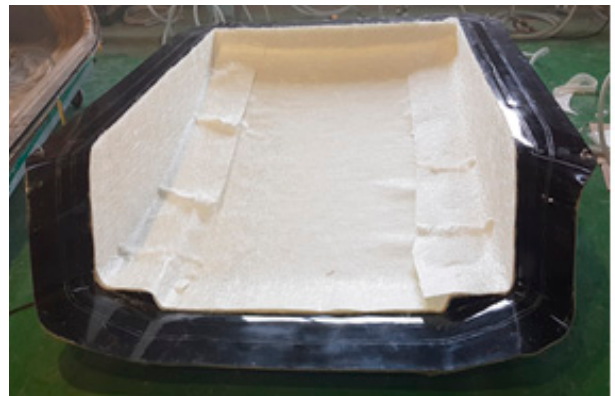
Figure 13. The lamination process of glass fiber.